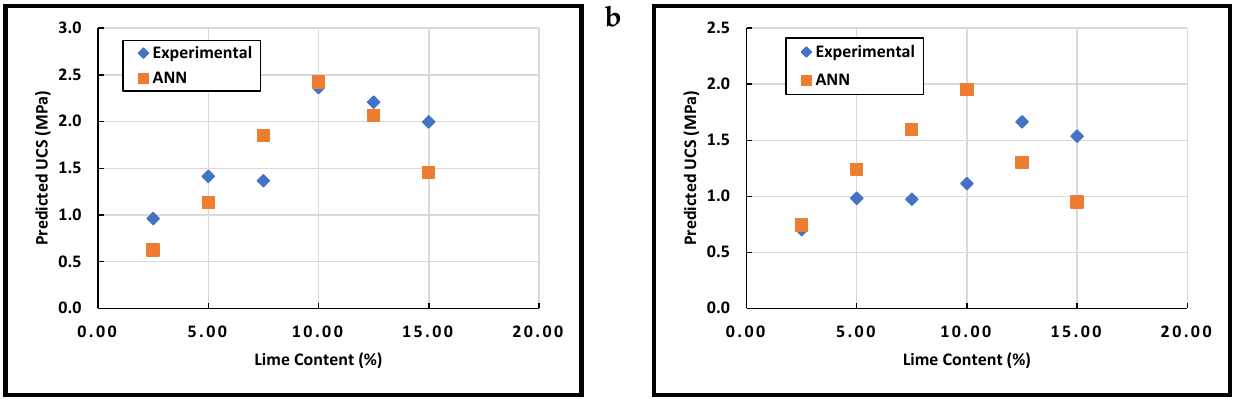
Figure 6. Model Validation for ( a ) Soil-1 and ( b ) Soil-2 (analyzed using the LIM-ANN network). Referring to the data in Figures 5 and 6 (Figures 5a and 6b, specifically), the difference between both the experimental and ANN data could be ascribed to the estimation of the variable by correlations which could affect the accuracy of prediction for the current study data. Moreover, the significant variation in the UCS values obtained in this study covers a wide range of soil properties. Unlike the data obtained from the literature, the two